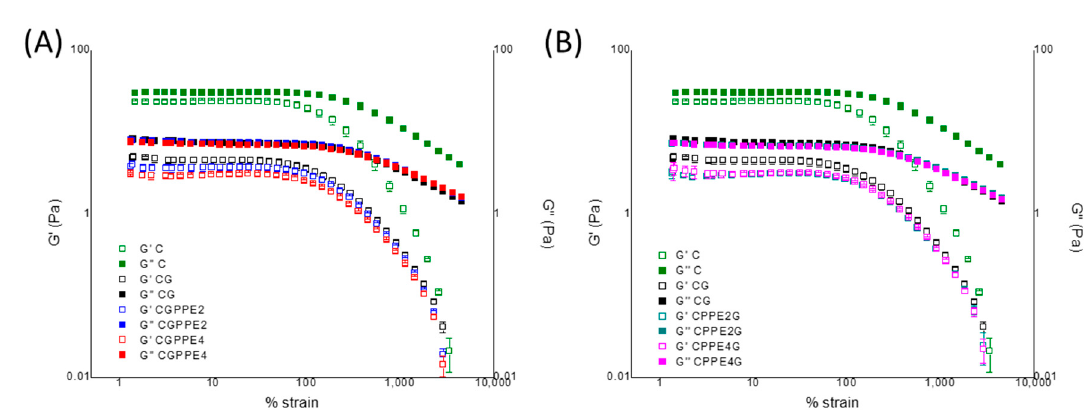
Figure 1. G (cid:48)(cid:48) and G (cid:48) moduli as a function of % strain, at 1 Hz frequency and 25 ◦ C, for: ( A ) C, CG, CGPPE2, and CGPPE4; and ( B ) C, CG, CPPE2G, and CPPE4G. Table 1. Parameters determined by strain sweep measurements: critical strain ( γ L ), G (cid:48) at the LVR limit (G (cid:48) LVR ), loss tangent value (tan δ ) and G (cid:48)(cid:48) –G (cid:48) moduli at 10% strain. Measurements were performed